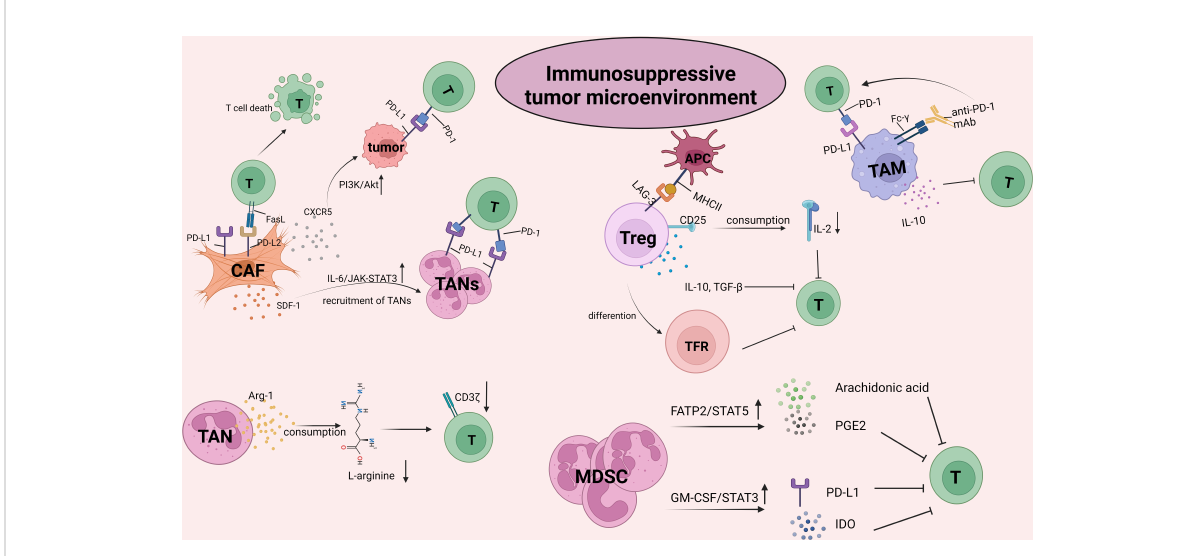
FIGURE 2 The crosstalk between CD8 + T cells and the other suppressive cells within tumor microenvironment (TME). TME is in fi ltrated by different types of innate and adaptive immune cells. The complex crosstalk between these immune cells and tumor cells determines the immune status and the implementation of T cell function, thus to facilitate or inhibit the tumor response to ICBs. With the progression of malignant cells, immune cells within TME, for example, macrophages and neutrophils, are educated into pro-tumor cells. As such, TME becomes progressively immunosuppressive. Immunosuppressive cells inhibit the activity of T cells by upregulating immune checkpoints, capturing anti-PD-1 antibodies and secreting pro-tumor soluble factors such as arg-1, IL-10, TGF- b , promoting tumor immune evasion and resulting in resistance to checkpoint inhibitors. The picture was created with BioRender.com. CAF, cancer associated fi broblasts; TAN, Tumor associated neutrophil; TAM, Tumor associated macrophage; MDSC, myeloid-derived suppressor cell; PGE2, prostaglandin E2; GM-CSF, granulocyte-macrophages colony- stimulating factor; IDO, indoleamine 2,3-dioxygenase; TFR, follicle-regulating T